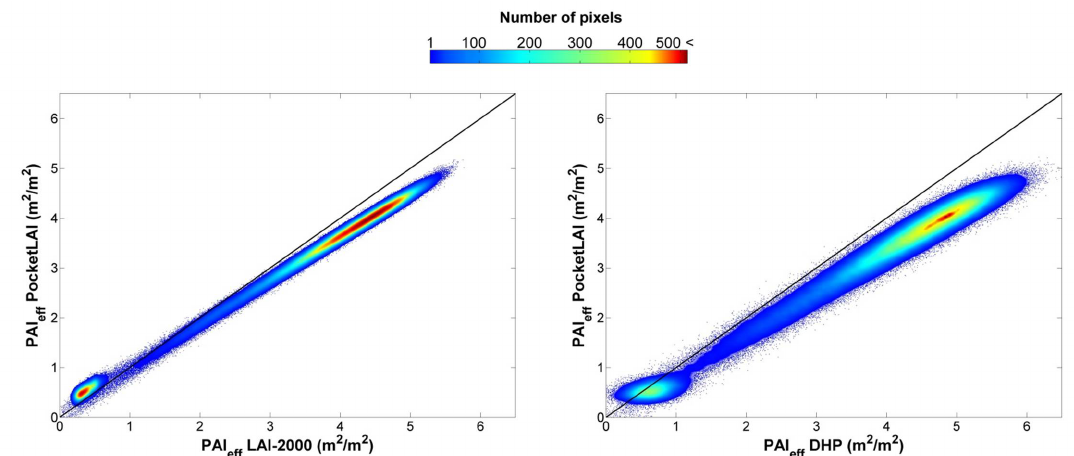
Figure 7. Scatterplots of PAI ef f estimates between PocketLAI and LAI-2000 ( left ) and DHP ( right